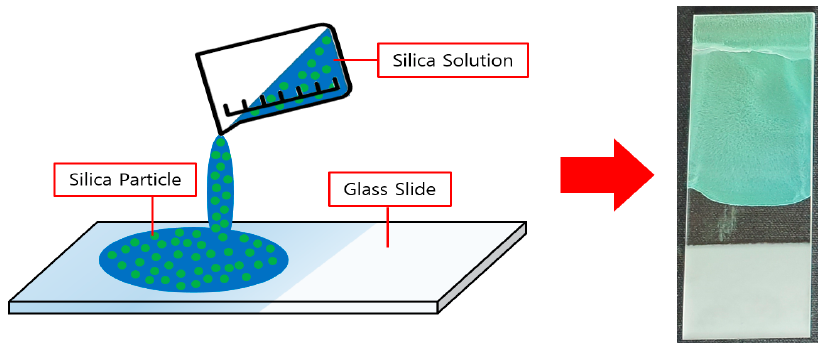
Figure 2. Coating process for the silica solutions.